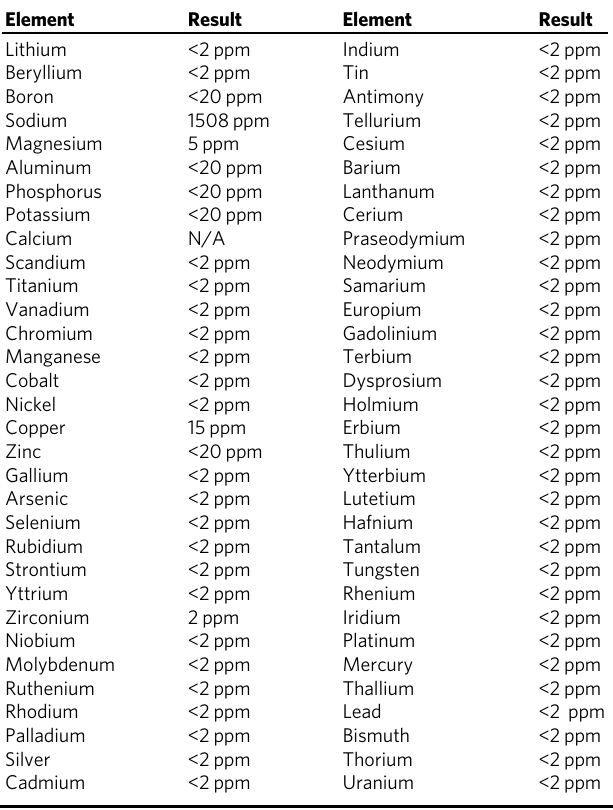
Table 2 ICP-MS analysis of ion species in the crystallization